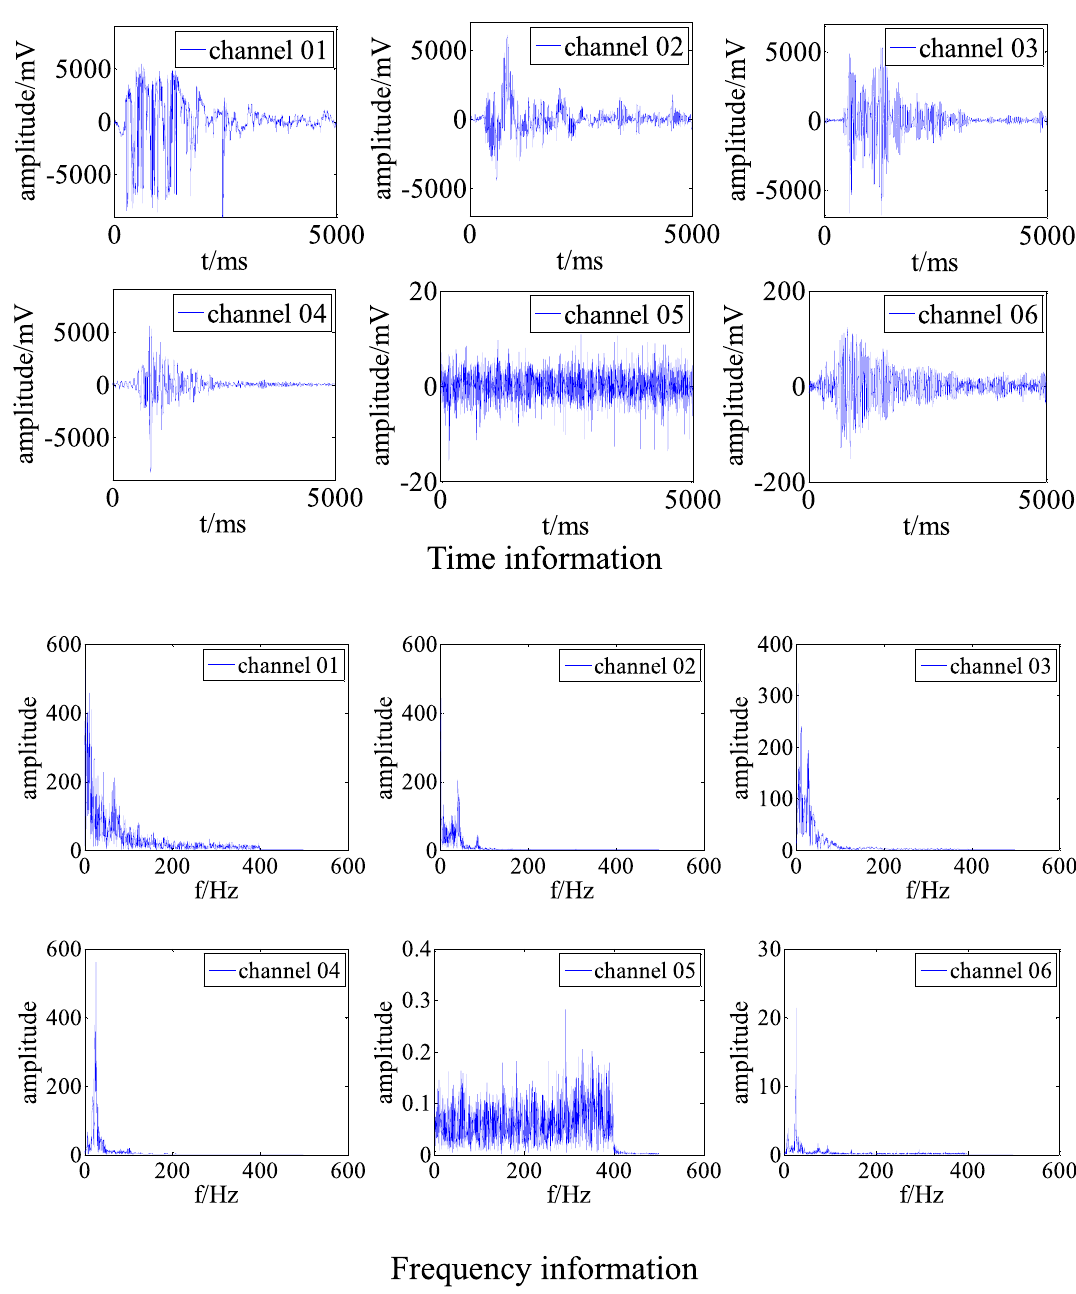
Figure 1. Multi-channel waveforms for a single event measured in the